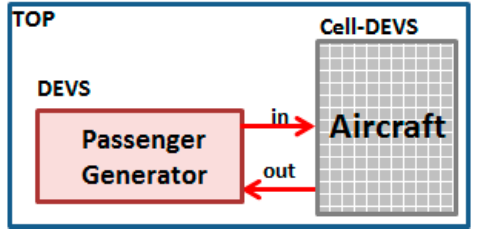
Figure 2. Discrete-Event System (DEVS) conceptual model of the system.